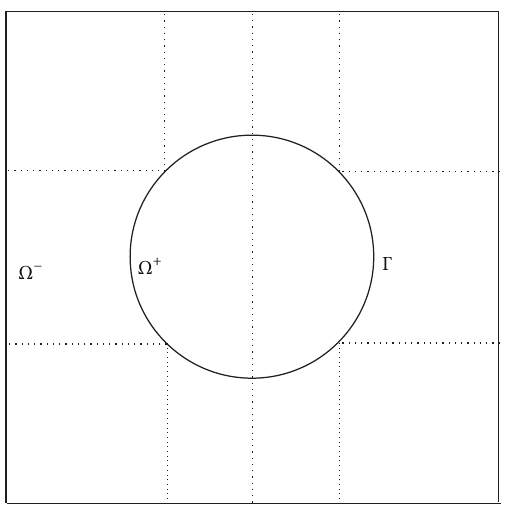
Figure 3: Domain decomposition for the interface examples. Table 1: Error discretization for Example 1 with ] = 0 . 𝑁 Legendre Chebyshev ‖𝑒‖ ‖𝑒‖ 0,𝑤,𝑁 1,𝑤,𝑁